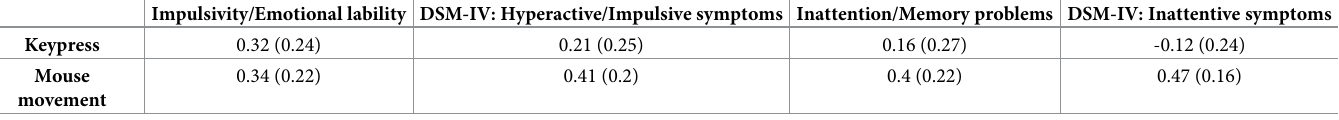
Table 19. Spearman’s ρ for correlations between predicted and test data in keypress and mouse movement conditions for scores on impulsivity and inattentiveness subscales.